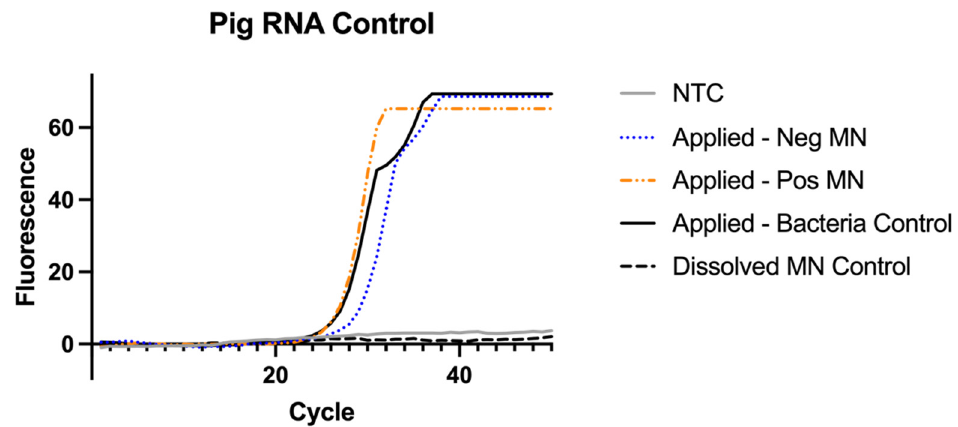
Figure 8. RNAse P Assay for extraction control results (n = 4). Samples from Figure 9 were re-run to test for the presence pig RNase P to ensure the MNs were applied long enough to the pig skin sample to collect RNA.